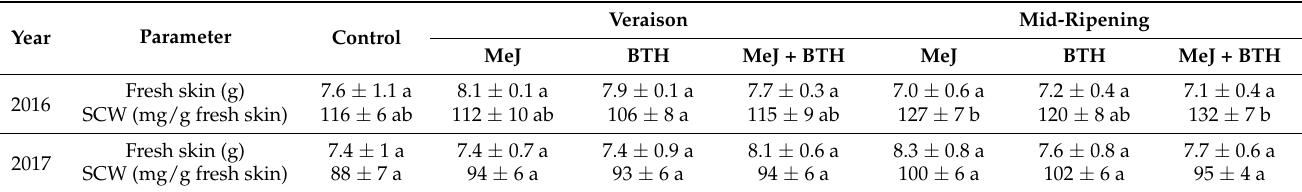
Table 1. Characteristics of grapes at harvest time during two seasons